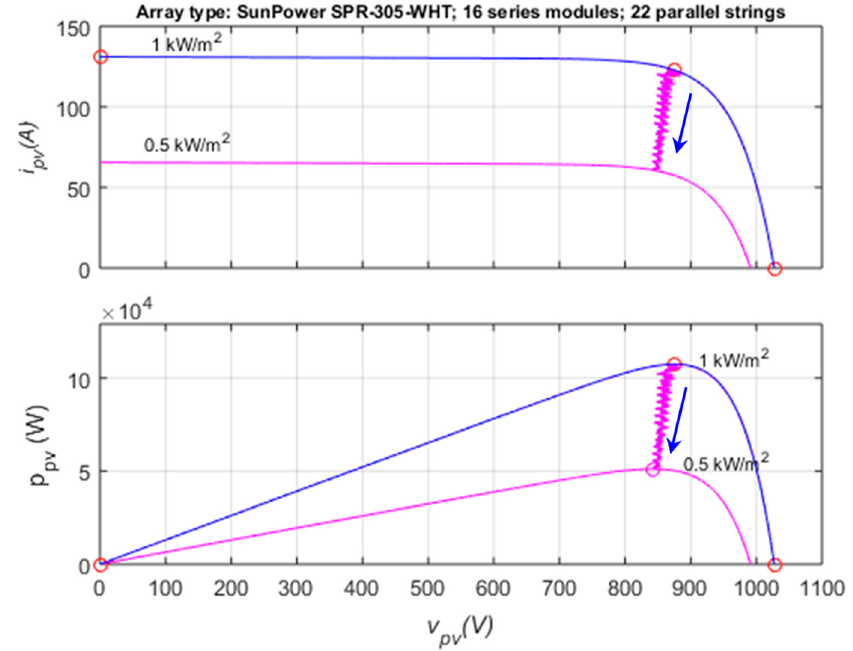
Figure 13. Effects of a 50% irradiance transient of PV power vs. PV voltage in case of irradiance ramp decrease.